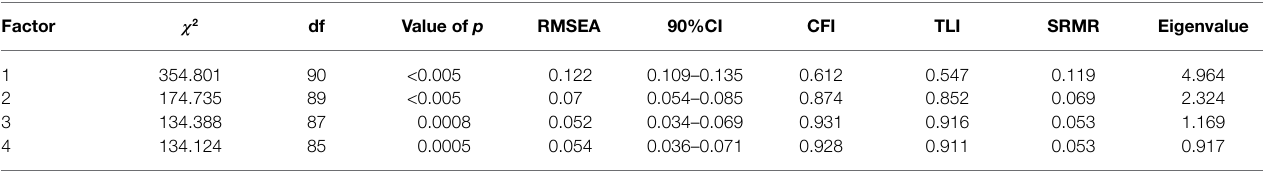
TABLE 2 | Model fit indices for the Interpersonal Needs Questionnaire.